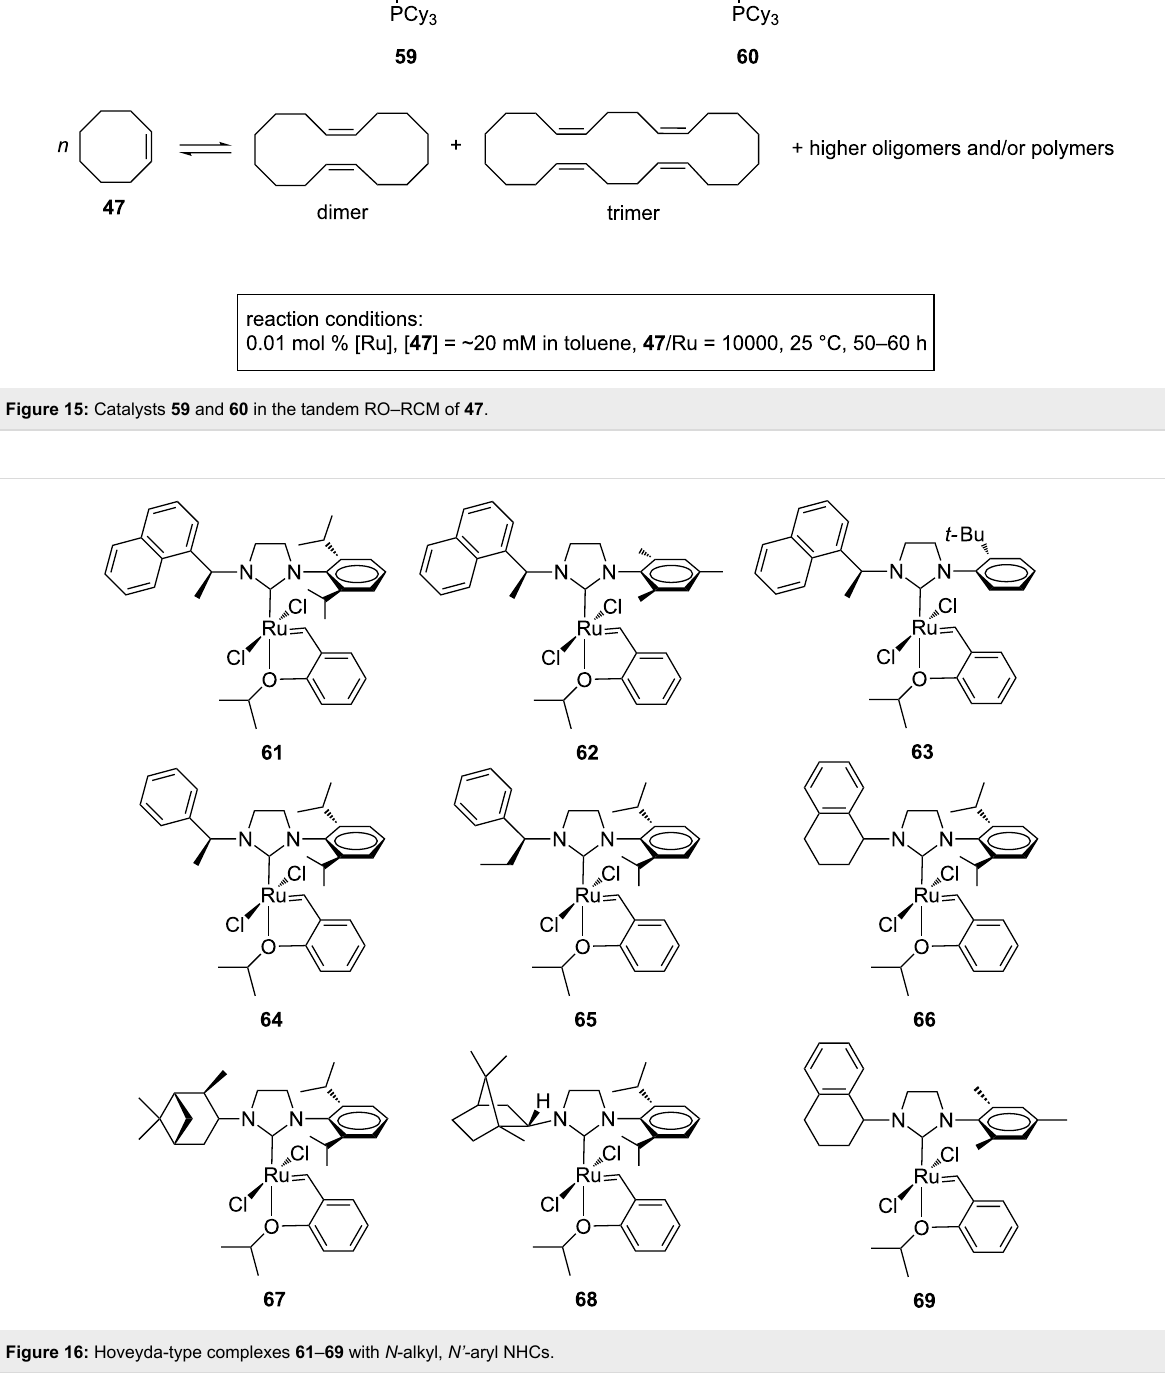
observed selectivity seems to be controlled by the NHC sterics, as increasing steric bulkiness of the NHC ligand leads to greater selectivity and improves stability.